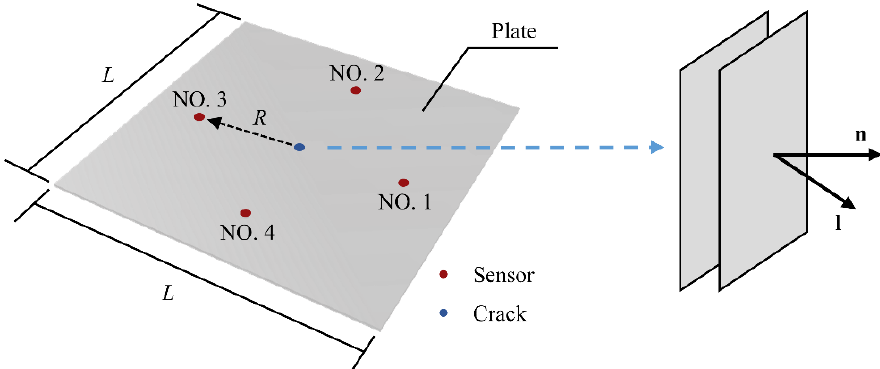
Figure 4. Sensor configuration and source (crack) location.